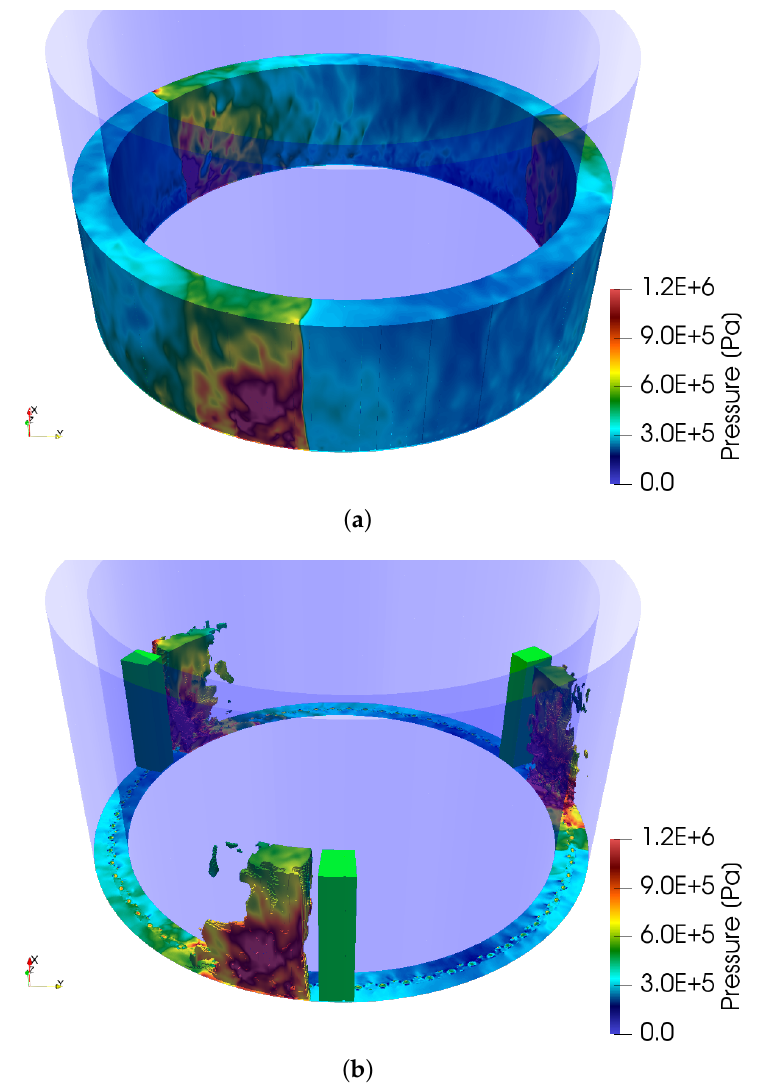
Figure 7. ( a ) Example RDRE annulus showing pressure of each wave at steady state, ( b ) extracted detonation waves pressure and detonation upstream regions in